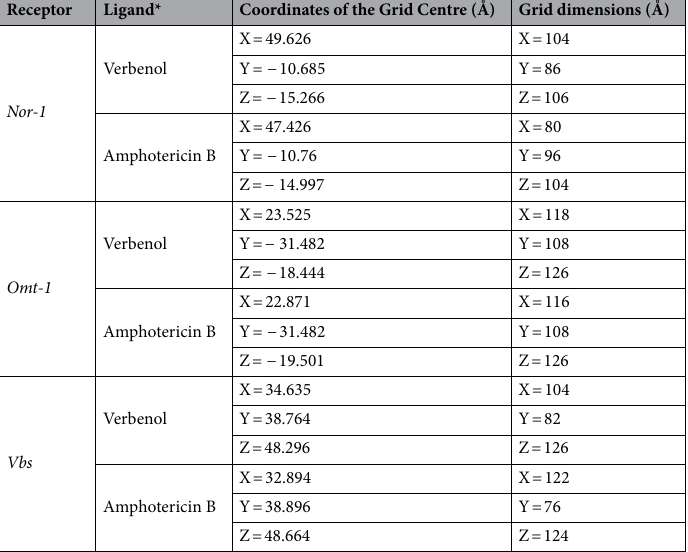
Table 2. Details of the docking environment used for the molecular docking study.